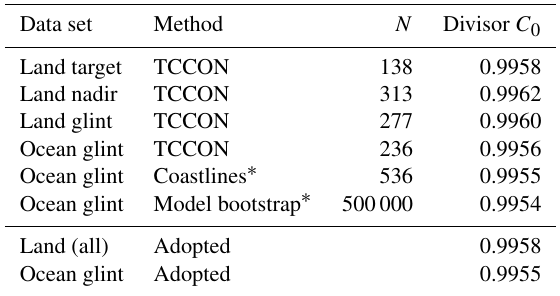
Table 11. Global scaling factors (divisors) for OCO-2 version